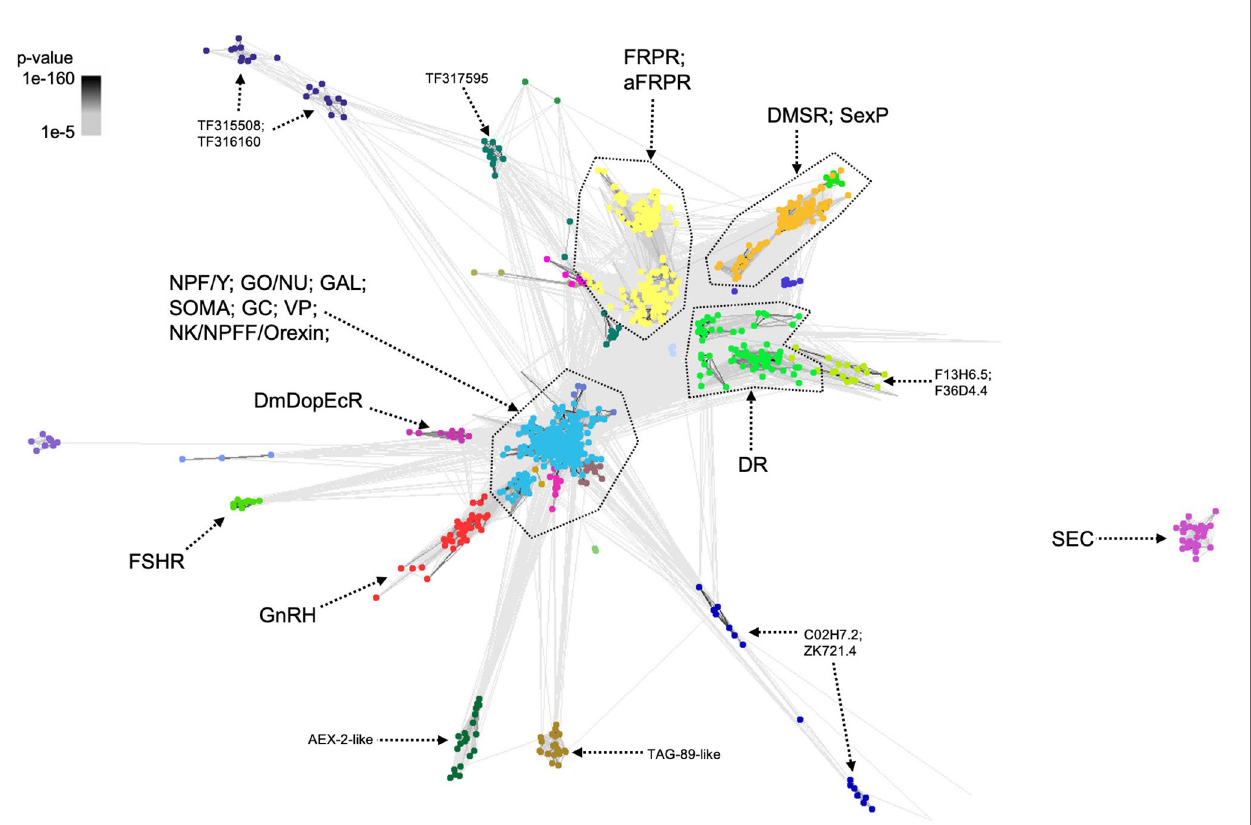
FIGURE 3 | CLANS analysis identi fi es NP-GPCR sub-families. Similarity matrix derived from all-against-all BLASTp comparisons between all identi fi ed nematode NP-GPCR sequences (E-value limit = 1e-5). NPF/Y, neuropeptide F/Y receptor family; SOMA, somatostatin receptor family; GAL, galanin receptor family; FRPR, FMRFamide Peptide Receptor family; aFRPR, another FMRFamide Peptide Receptor family; DMSR, Drosophila myosuppressin receptor family; GO/NU, Ghrelin-obstatin/neuromedin U receptor family; NK/NPFF/Orexin, Neurokinin/neuropeptide FF/orexin receptor family; GnRH, Gonadotropin-releasing hormone receptor family; GC, Gastrin-cholecystokinin receptor family; VP, Related Vasopressin receptor family; SexP, Related to Sex peptide receptor family; DR, related to fl y ortholog (TF315326), plus related family (TF315359); TAG-89-like, Related family with no speci fi c orthologs (TF318526); AEX-2-like, Related family with no speci fi c orthologs (TF316587); TF317595, Related family with fl y ortholog; TF315508, Related family with no speci fi c orthologs; TF316160, Related family with no speci fi c orthologs; FSHR, follicle-stimulating hormone receptor; DmDopEcR, Drosophila Dopamine/Ecdysteroid receptor; SEC, secretin- type